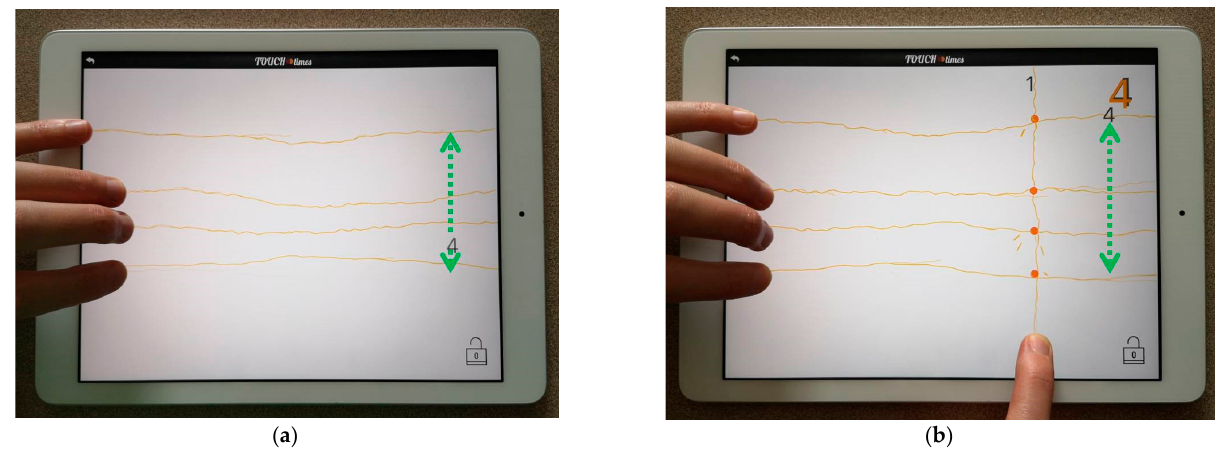
Figure 12. ( a ) Four horizontal lines and the numeral “4”, ( b ) One four-ple on the vertical line (The green arrows are added on the figures to illustrate the path the numerals follow).